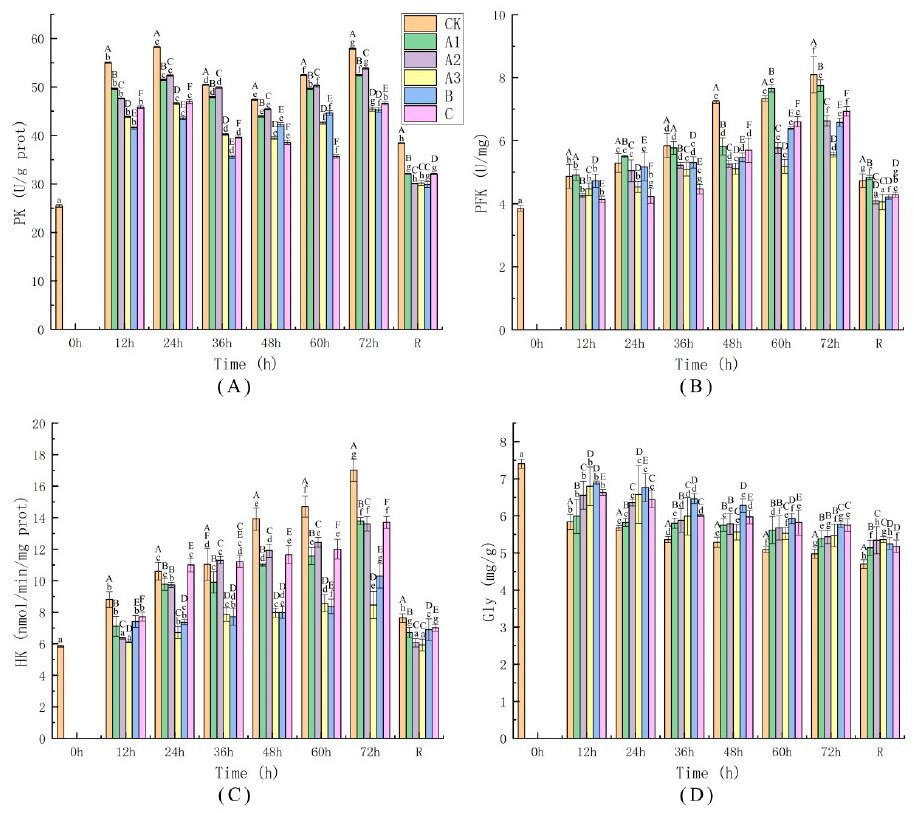
Figure 3. The activity changes of Pyruvate kinase (PK; ( A )), Phosphofructokinase (PFK; ( B )) and hexokinase (HK; ( C )), concentrations of hepatic glycogen (Gly; ( D )). Sea bass ( Lateolabrax maculatus ) were sampled at different time intervals in all six groups. CK: no sedative of anaesthetic addition, A1: 10 mg/L MOEO, A2: 20 mg/L MOEO, A3: 40 mg/L MOEO, B: 30 mg/L MS-222, C: 20 mg/L eu- genol. After 0, 12, 24, 36, 48, 60, and 72 h exposure or 12 h after recovery (R). Vertical bars indicate standard deviation; Means with different lowercase letters indicate a significant difference between time intervals within each group ( p ≤ 0.05); While different capital letters indicate significant differ- ences between groups in each time interval ( p ≤ 0.05).